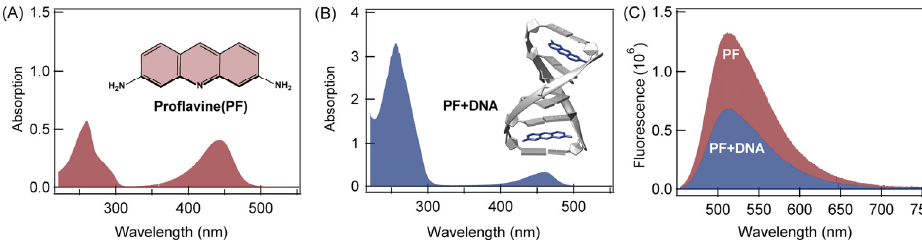
Figure 1. ( A ) The absorption spectra of proflavine in buffer solution (pH = 7.4) and the chemical structure of proflavine; ( B ) the absorption spectra and structure of the intercalation complex of proflavine-DNA (PF-DNA) in buffer solution (pH = 7.4); ( C ) fluorescence emission spectra of 5 μ M proflavine and fluorescence emission spectra of 5 μ M proflavine with 2.5 μ M DNA in buffered solution (pH = 7.4).